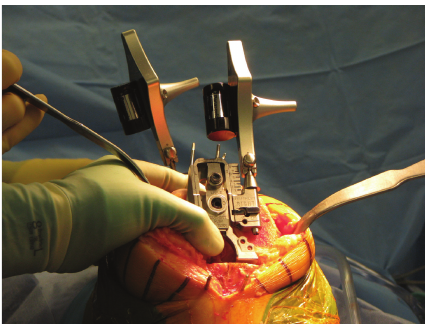
Figure 2: Stryker Triathlon reference jig used for comparison of landmark methods, force sensor technique, and posterior condyles